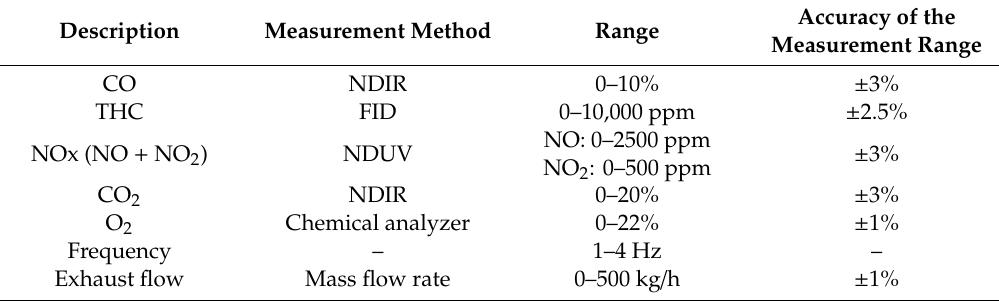
Table 3. Technical parameters of the measurement equipment (SEMTECH DS).